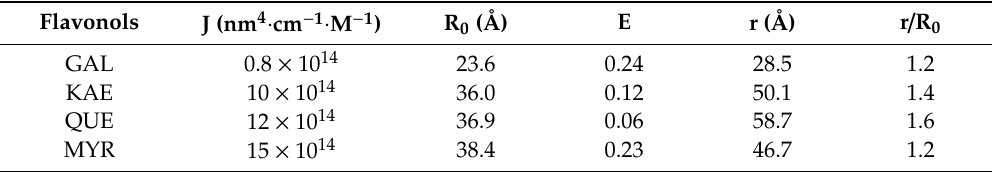
Table 3. The distance parameters calculated between the binding sites of CpLIP2 lipase and flavonols according to the chemical conditions previously described. GAL, galangin; KAE, kaempferol; QUE, quercetin; MYR, myricetin.